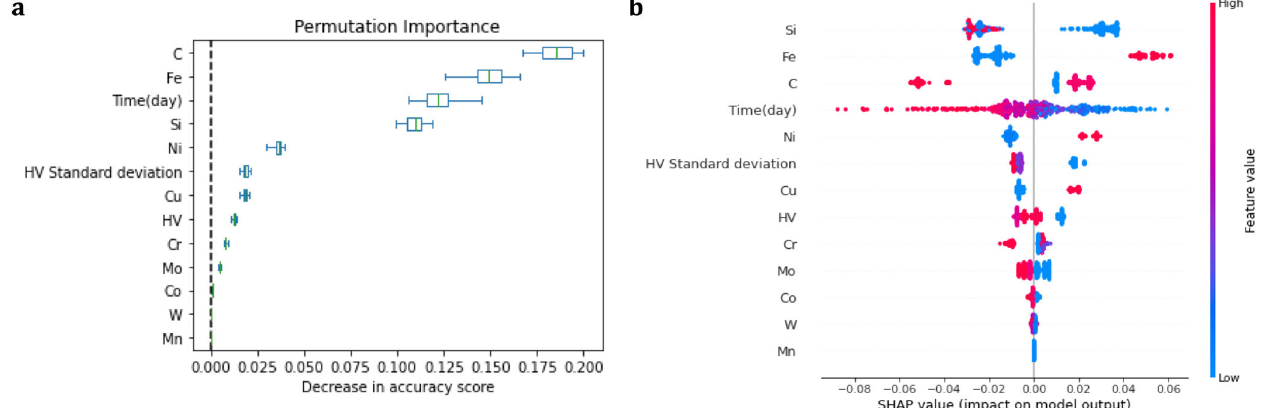
Fig. 6 Feature importance analysis for GBR model. Feature importance as given by the permutation importance and SHAP value based on the GBR E corr model: a Box plot of the feature contributions by permutation importance with the minimum and maximum score, lower and upper quartile, and mean value of various features versus its decrease in accuracy score of models; b Distribution plot of the feature contributions by the SHAP value. High feature value is colored with red and low feature value is colored with blue. GBR gradient boosting regression, SHAP Shapley Additive